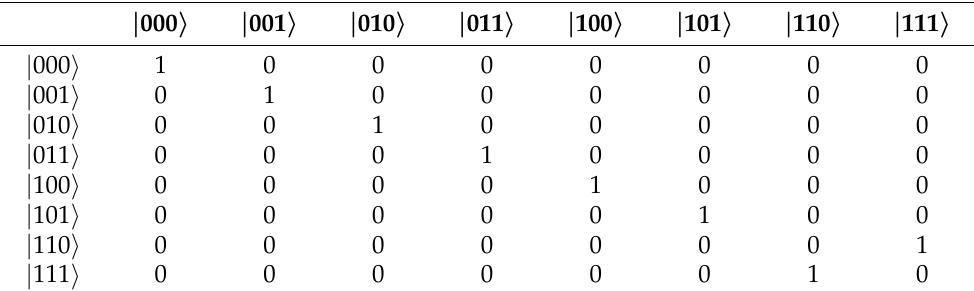
Table 5. Unitary matrix associated to the truth table of the CCN